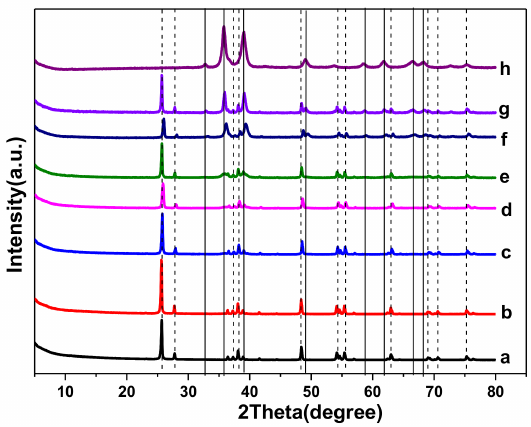
Figure 1. XRD patterns of ( a ) pure TiO 2 , ( b ) CuO/TiO 2 -1, ( c ) CuO/TiO 2 -2, ( d ) CuO/TiO 2 -3, ( e ) CuO/TiO 2 -4, ( f ) CuO/TiO 2 -5, ( g ) CuO/TiO 2 -6, and ( h ) pure